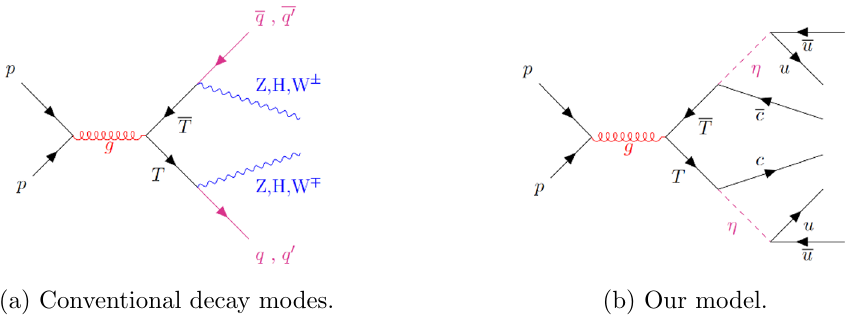
Figure 1. Feynman diagrams for the conventional decay modes and the processes considered in this